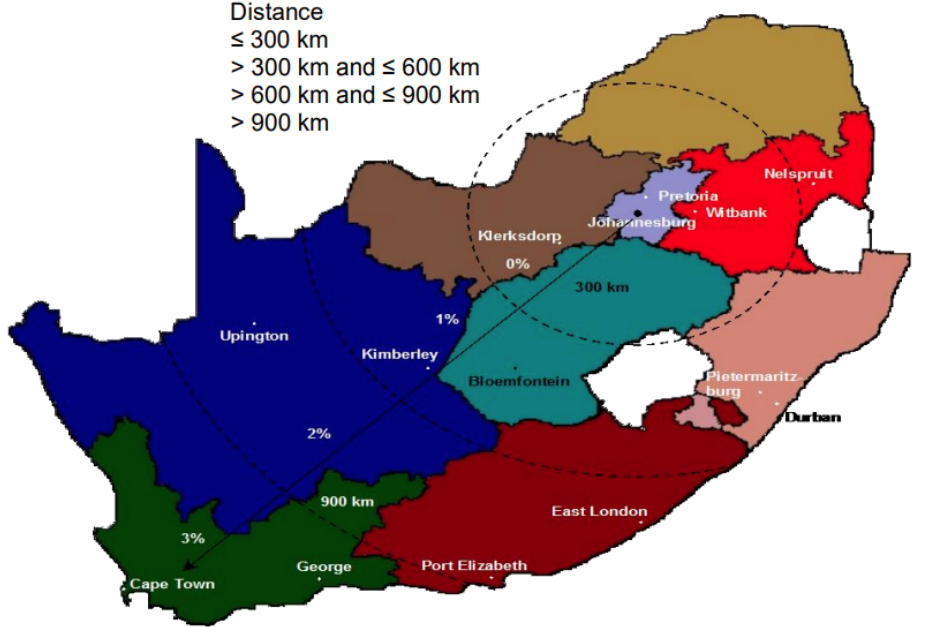
Figure 4. Transmission zones for loads [39].